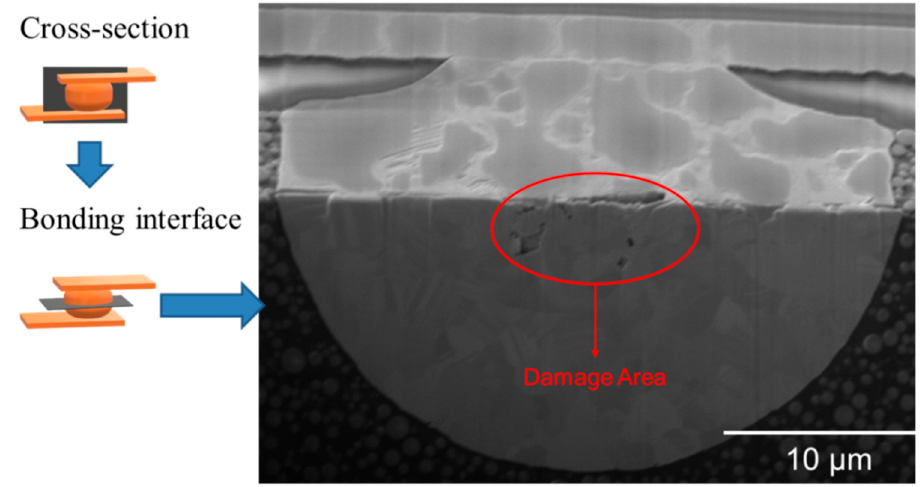
Figure 6. Typical FIB image of the joints bonded at 300 °C/90MPa/30 s prior to thermal cycling tests. Various cracks and/or voids pre-existed in the central region. Under thermal cycling, they tend move from the high stress regions toward the lower stress vicinities.